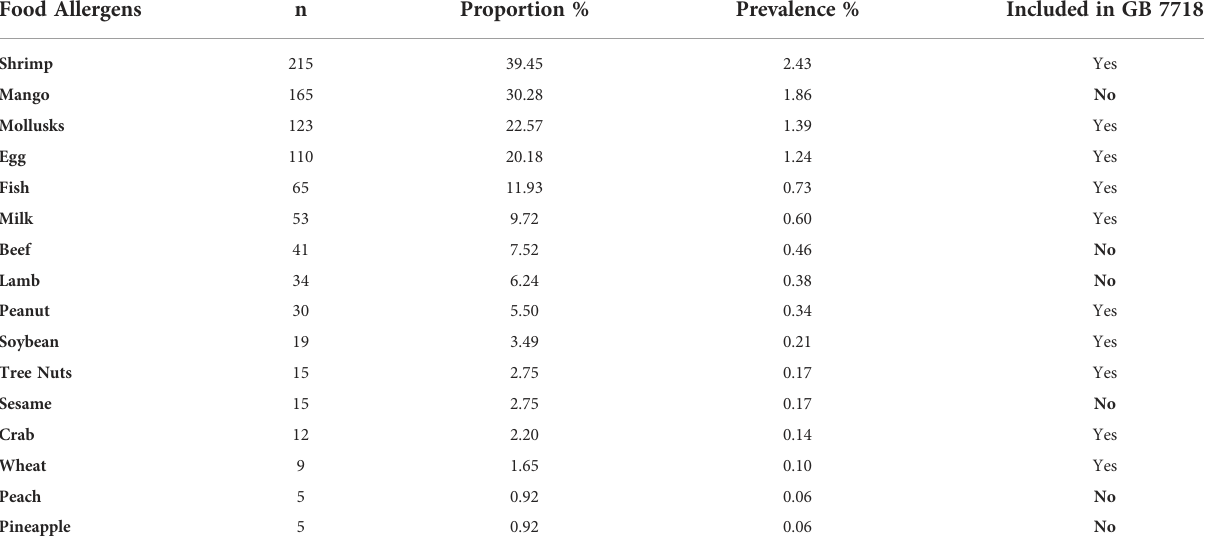
TABLE 2 Summary of the common food allergens of parent-reported food allergy.